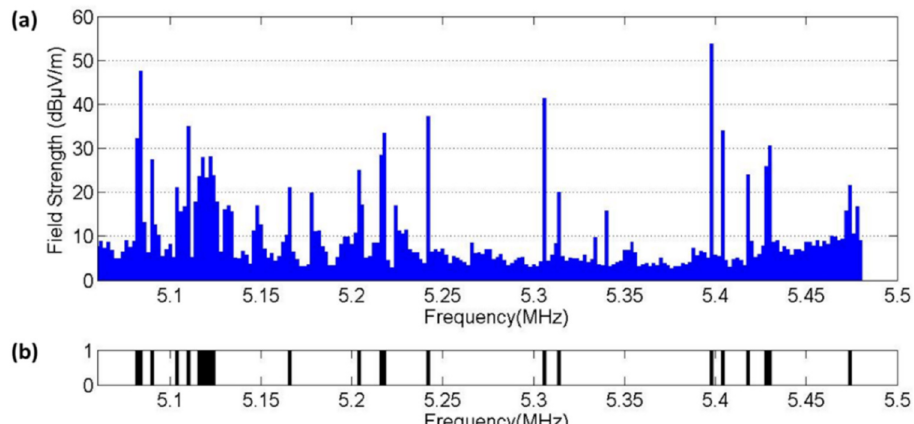
Figure 2. Congestion measurement within an ITU allocation.